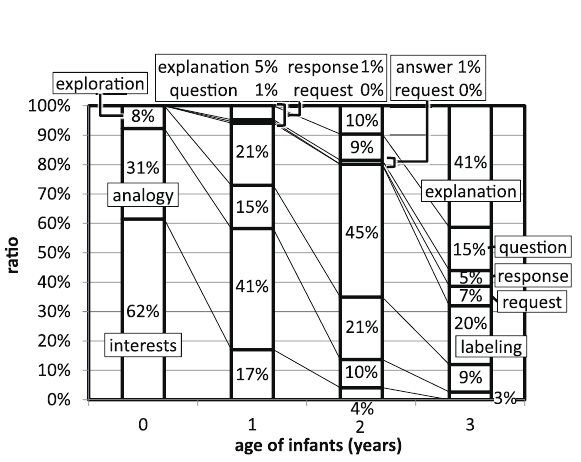
Fig. 3. Frequencies of the Intentions of Pointing Behaviors Accompanied by Vocalizations